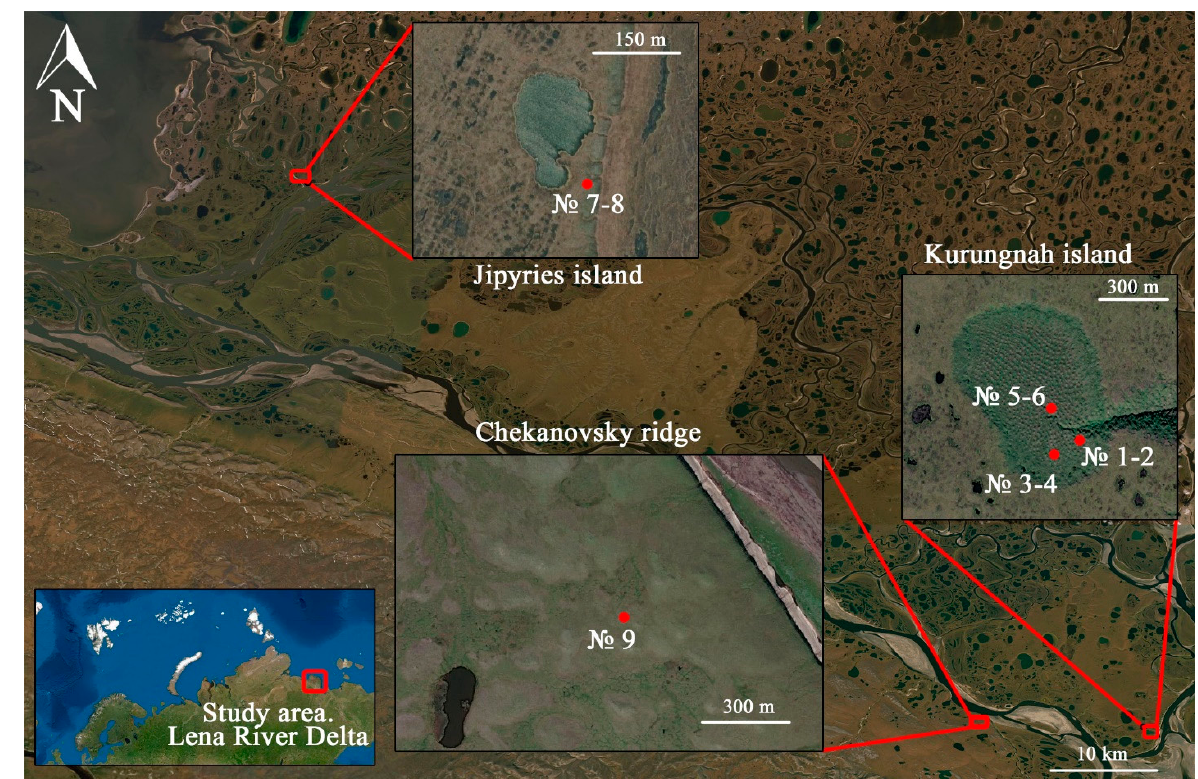
Figure 1. Study area: Lena River delta. Soil numbers correspond to Table 1.